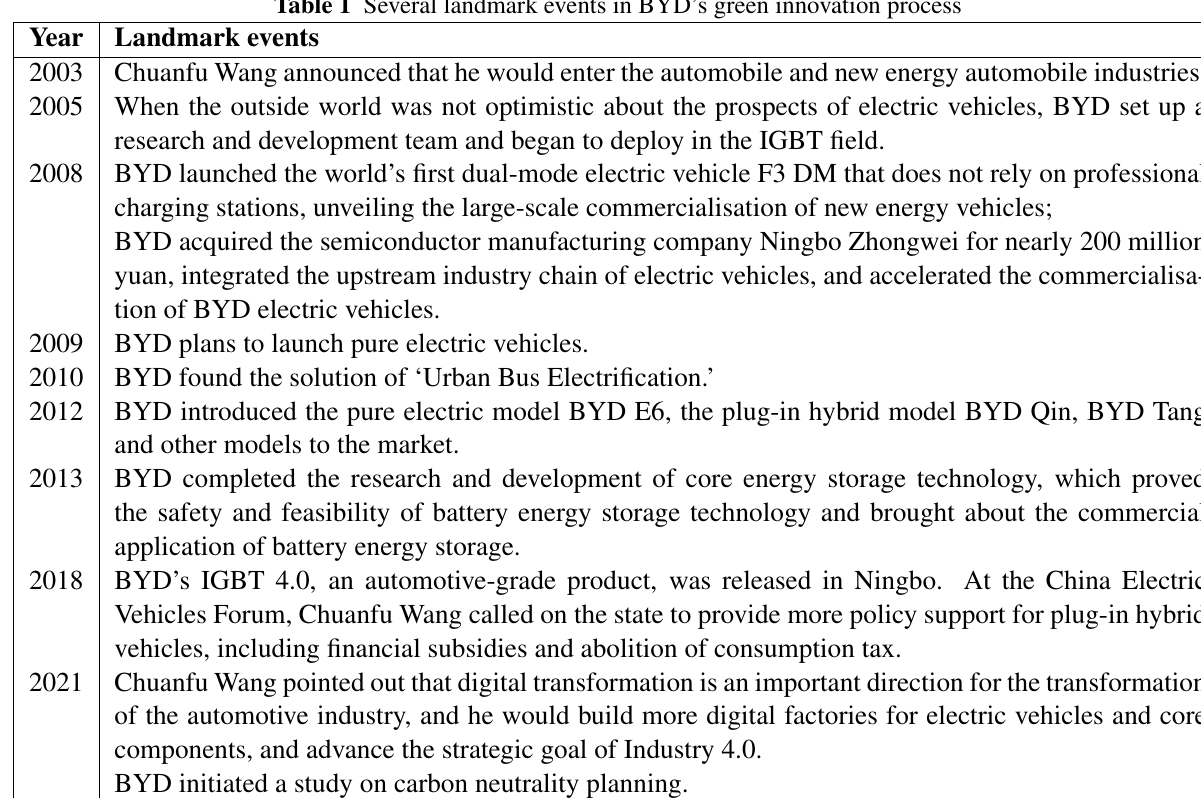
Table 1 Several landmark events in BYD’s green innovation